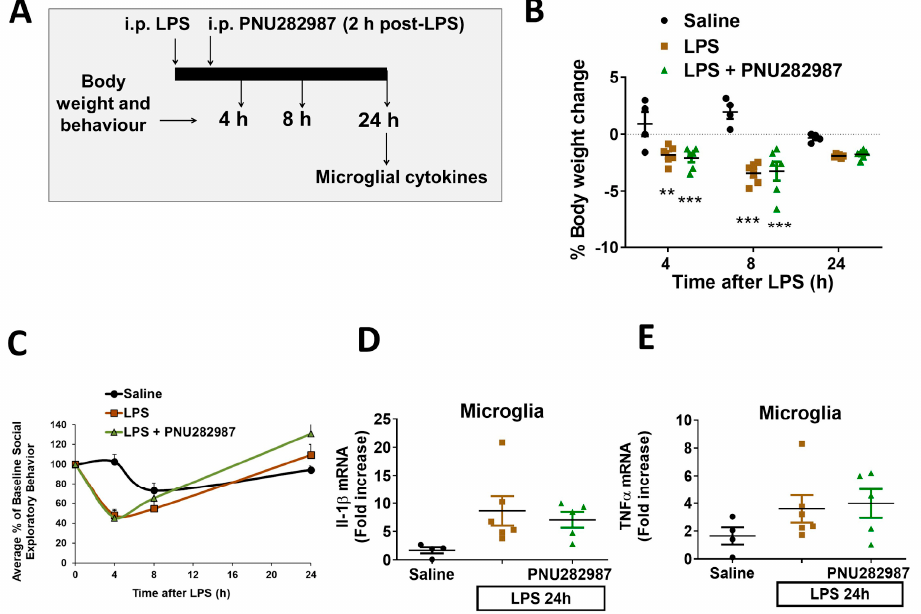
Figure 4. Delayed activation of α 7 nAChRs by PNU282987 i.p. administration does not reduce sickness behavior or neuroinflammation induced by LPS. ( A ) Experimental protocol used. Adult (3–4 months old) Balb/c mice were injected i.p. with LPS 0.33 ± 10 mg/kg PNU282987, 2 h post-LPS. ( B ) Body weight change and ( C ) social exploratory behavior measured 4, 8 and 24 h post-treatment (saline, LPS, LPS + PNU282987). Microglial mRNA levels of IL-1 β ( D ) and TNF α ( E ) 24 h post-treatments (saline, LPS or LPS + PNU282987). Data are represented as the mean and S.E.M (4–6 animals per group). Comparisons were made using one-way ANOVA ( D , E ) and two-ways ANOVA ( B , C ). ** p < 0.01, *** p < 0.001 vs. saline.